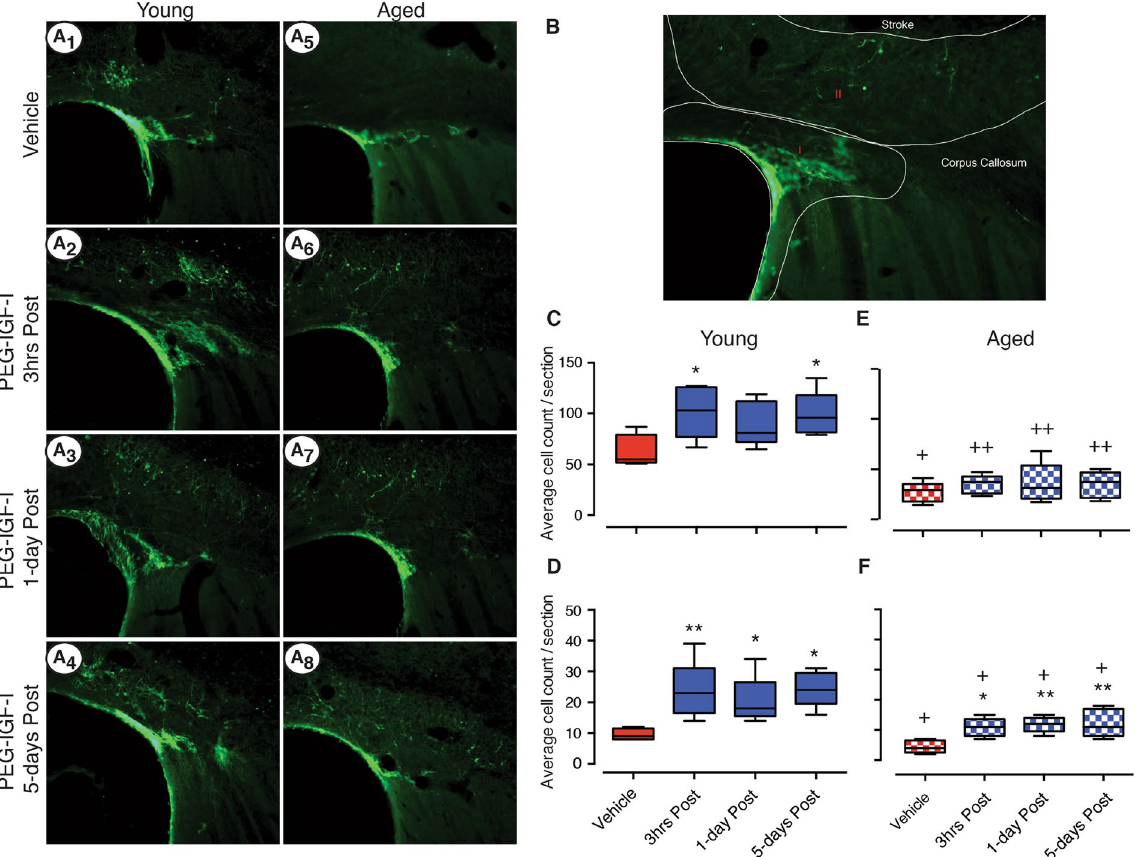
Figure 5. PEG-IGF-I stimulates the migration of neuroblasts in vivo after stroke in both young and aged mice 14-days post-stroke. Representative images of DCX + cells migrating from the lateral ventricle are shown for stroke + vehicle, stroke + 1 mg/kg PEG-IGF-I from 3 hrs, stroke + 1 mg/kg PEG-IGF-I from 1-day and stroke + 1 mg/kg PEG-IGF-I from 5-days post-stroke for young ( A1 , A2 , A3 and A4 respectively) and aged ( A5 , A6 , A7 and A8 respectively) animals. Panel B shows a sample photomicrograph illustrating the regions where cells were counted. Region A is next to the lateral ventricle including the bottom half of the corpus callosum, whereas region B is counts that include the top half of the corpus callosum and surrounding the stroke cavity. Box and whisker plots show the average cell counts from three section per animal of n = 5 animals per treatment group for each of the two regions ( C and D for regions I & II respectively) for young and ( E and F for regions I & II respectively) for aged. * P < 0.05, ** P < 0.01 compared to stroke + vehicle treated controls controls; + P < 0.05, ++ P < 0.01 compared to the equivalent young treated